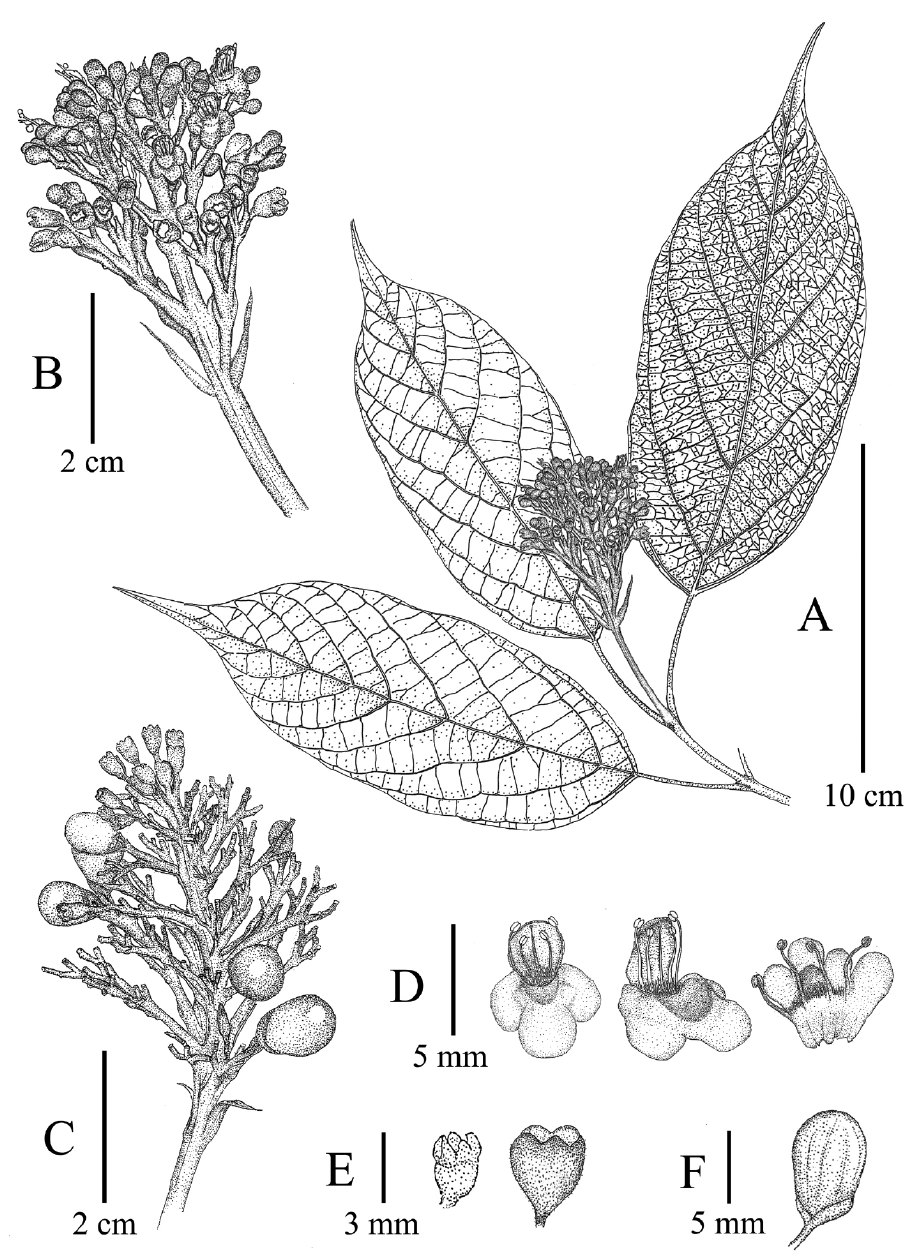
Figure 3. Line drawing of Premna bhamoensis Y. T. Tan & B. Li, sp. nov. A abranchlets with inflorescence B inflorescence C fruitescence D corolla E calyx in flowering (left) and fruiting (right) F